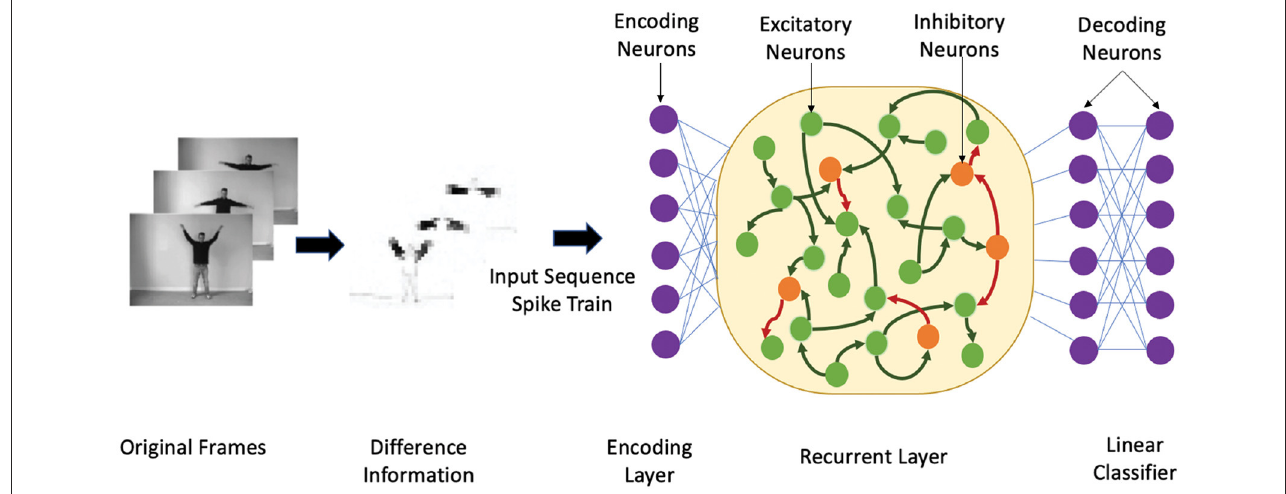
FIGURE1 An illustrative example showing the heterogeneous recurrent spiking neural network structure. First, we show the temporal encoding method based on the sensory receptors receiving the difference between two time-adjacent data. Next, the input sequences are encoded by the encoding neurons that inject the spike train into 30 % neurons in R . R contains a 4 : 1 ratio of excitatory (green nodes) and inhibitory (orange nodes), where the neuron parameters are heterogeneous. The synapses are trained using the heterogeneous STDP method.